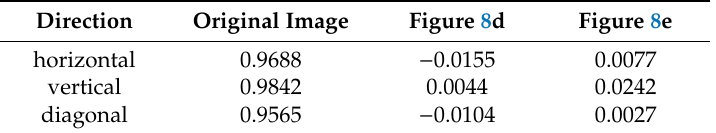
Table 2. Correlation coe ffi cients of two adjacent pixels in the original image and Figure 8d,e. Direction Original Image Figure 8d Figure